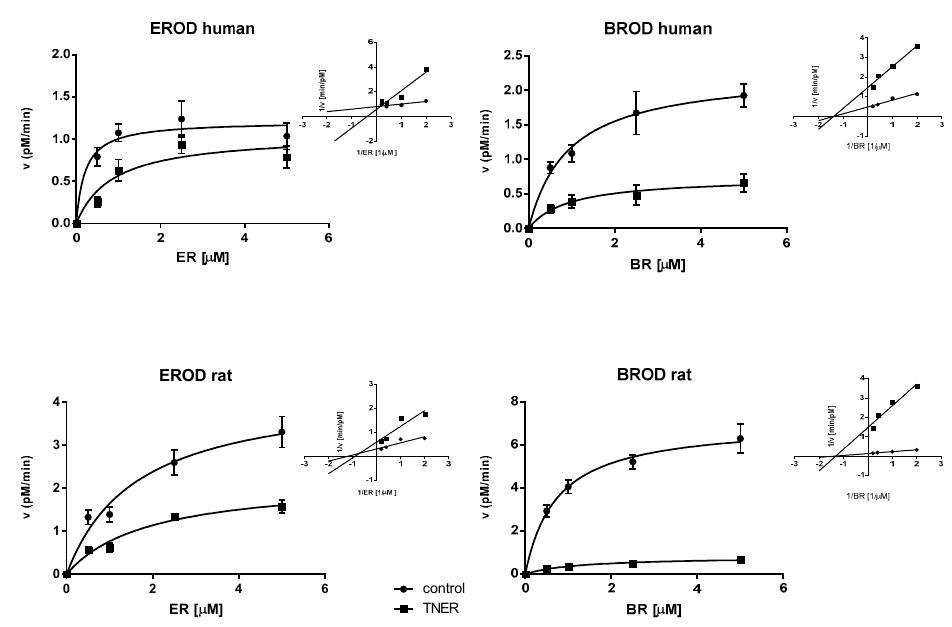
Figure 2. Michaelis-Menten plot of EROD and BROD activities in control and 5 µM TNER inhibited reactions. The human CYP1A2 (EROD human) was competitively inhibited and rat CYP1A2 (EROD rat) non-competitively. BROD activity was inhibited non-competitively by TNER both in human and rat. Human and rat liver microsomes were incubated with 0.5–5.0 µM ethoxyresorufin (ER) or benzyloxyresorufin (BR) in the absence (control) or presence of TNER. Lineweaver-Burke plots show the type of inhibition. Table 4. Kinetic parameters obtained for CYP1A2 (EROD activity) after incubation of human and rat liver microsomes with ethoxyresorufin (0.5–5.0 µ M) in the presence (K’ M , V’ MAX ) or absence (K M , V MAX ) of TNER (5 µ M), and for CYP2B/3A (BROD activity) after incubation of human and rat liver microsomes, with benzyloxyresorufin (0.5–5.0 µ M) in the presence (K’ M , V’ MAX ) or absence (K M , V MAX ) of TNER (5 µ